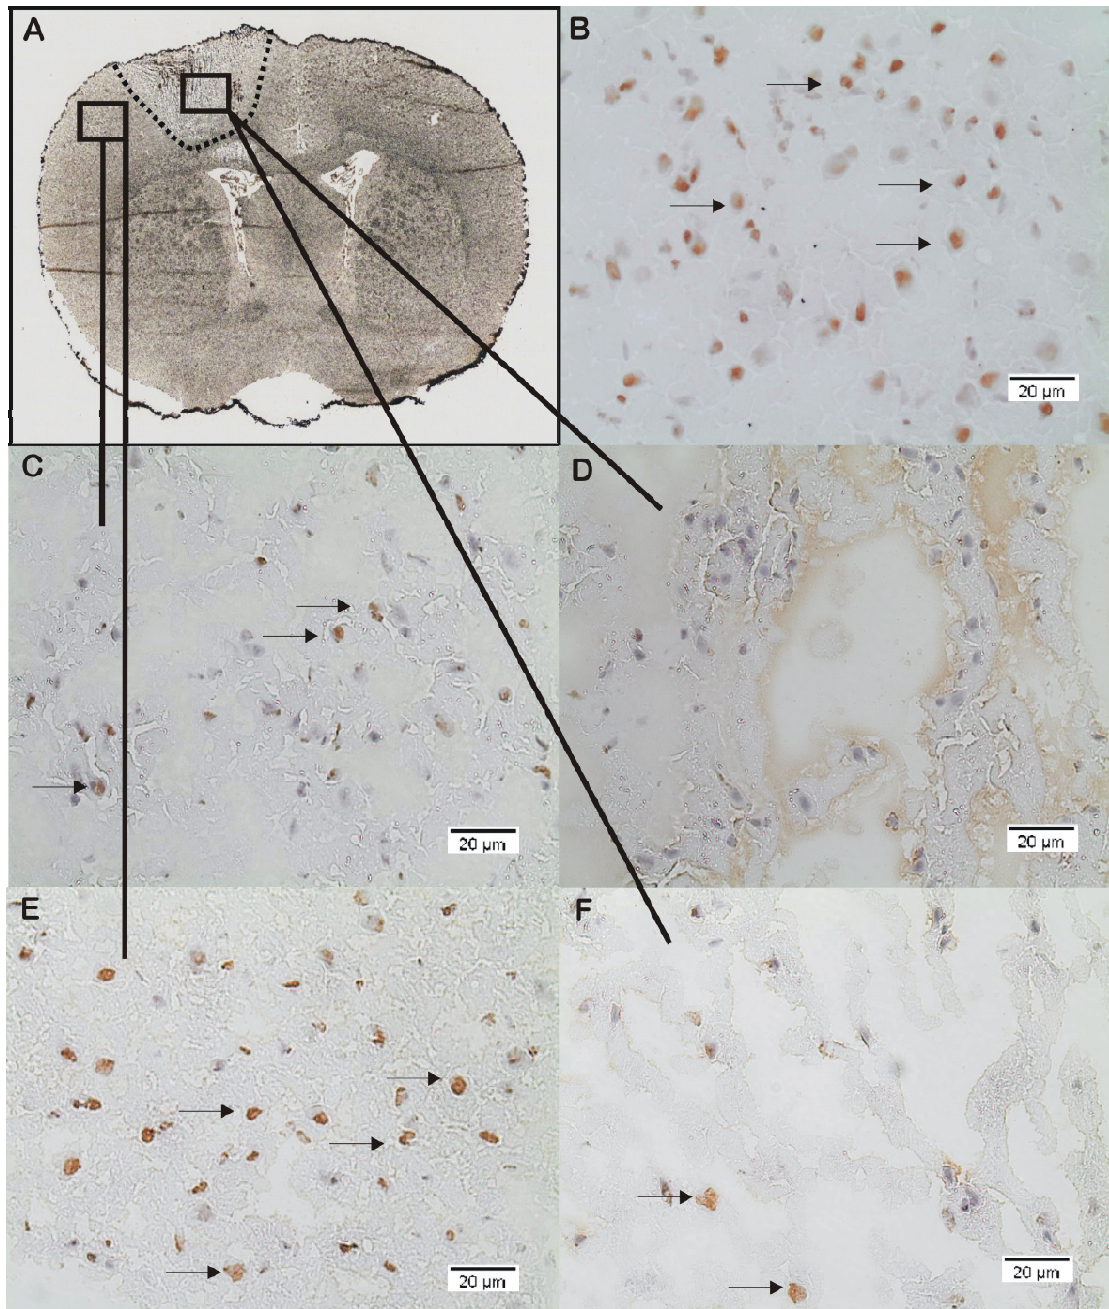
Figure 2. ( A ) Silver-staining and overview of rat brain cryosection 8 h after controlled cortical impact injury (CCII), indicating the TBI lesion (----: line). ( B – F ) Immunohistological staining and expression of ADMA (magnification: 200×); ( B ) ADMA expression in subcortical brain area of control animals, equivalent to the lesion and perilesional area of TBI animals; ( C ) ADMA expression within the perilesional area 8 h after CCII; ( D ) ADMA expression within the TBI lesion 8 h after CCII. No positively stained cells are detectable within this FOV. ( E ) and ( F ) ADMA expression 24 h after CCII; ( E ) The perilesional zone shows an increase in ADMA expression 24 h after CCII compared to 8 h after CCII; ( F ) ADMA within the TBI lesion 24 h after CCII. Only very few positively stained cells are detectable ( → : examples for positively stained